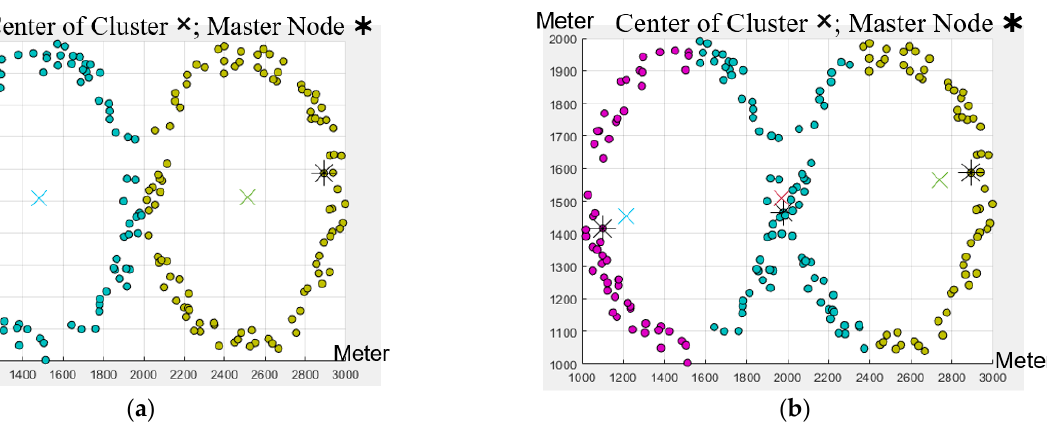
Figure 5. Multi-master cases: ( a ) Two-masters case. ( b ) Three-masters